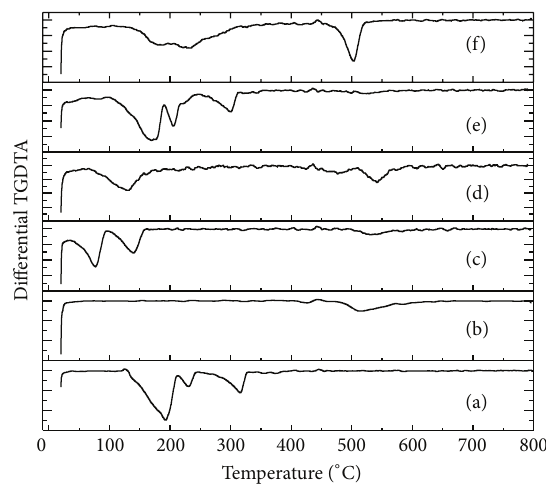
Figure 17: Differential